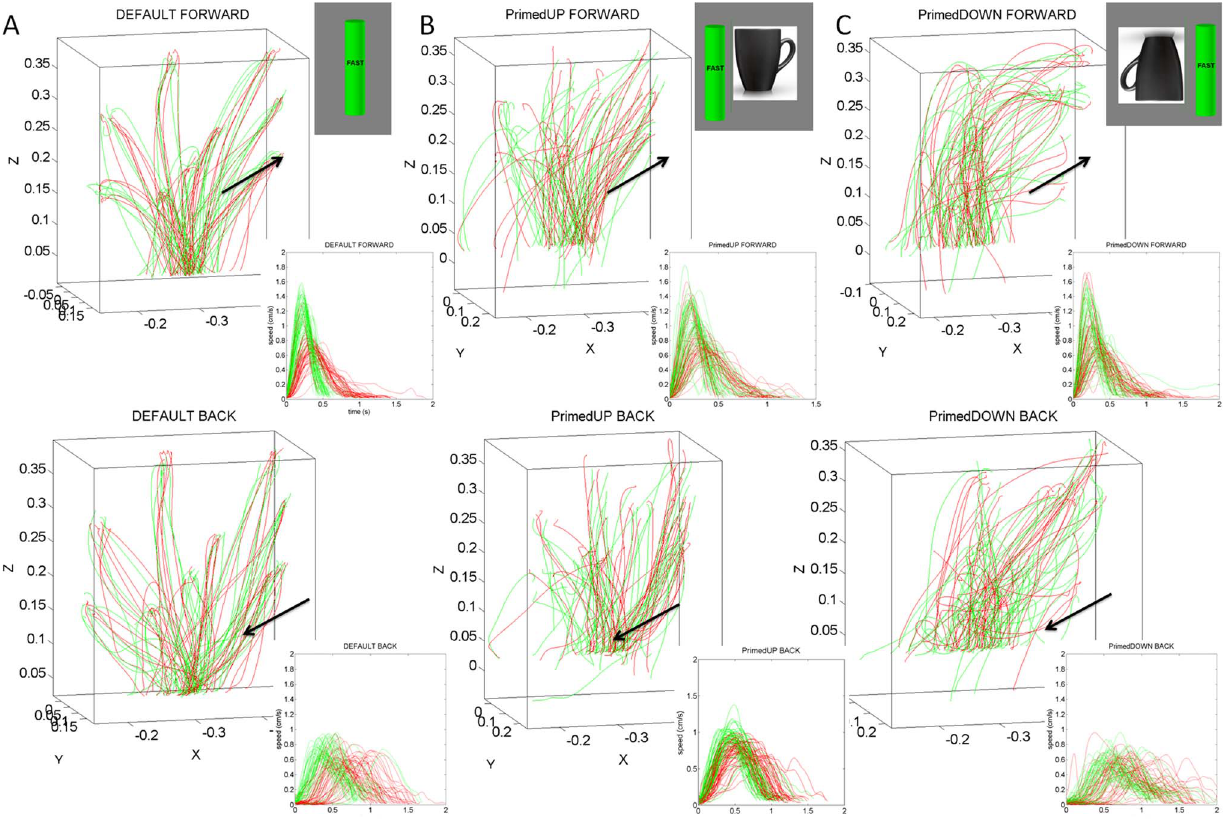
Figure 7. Effects of priming on the movement trajectories at the wrist in typical patient within PD1 group using two different levels of speeds randomly cued. (A) DEFAULT forward motion trajectories with corresponding speed profiles for slow (red) and fast (green) cases. Inset shows the actual stimuli on the screen priming the subject to match the orientation of the rod on the screen (vertical in this case) with the hand-held rod. Top are the forward paths and bottom are the retracting motions. (B) Primed-UP cases evoked similar final orientations as the DEFAULT condition. The inset shows the priming cup with handle next to the original rod. (C) Primed-DOWN condition changed the trajectories in both the forward and retracting cases. The inset shows the priming condition where the arm and hand underwent complex rotations. The instruction was to match the orientation of the rod on the screen as if the hand were to gasp the handle of the cup to drink from it. Notice the dramatic differences in trajectories for all target positions. Retracting speed profiles in both primed-DOWN and primed-UP condition in PD1 group do not have statistically significant differences for instructed fast and slow speeds.